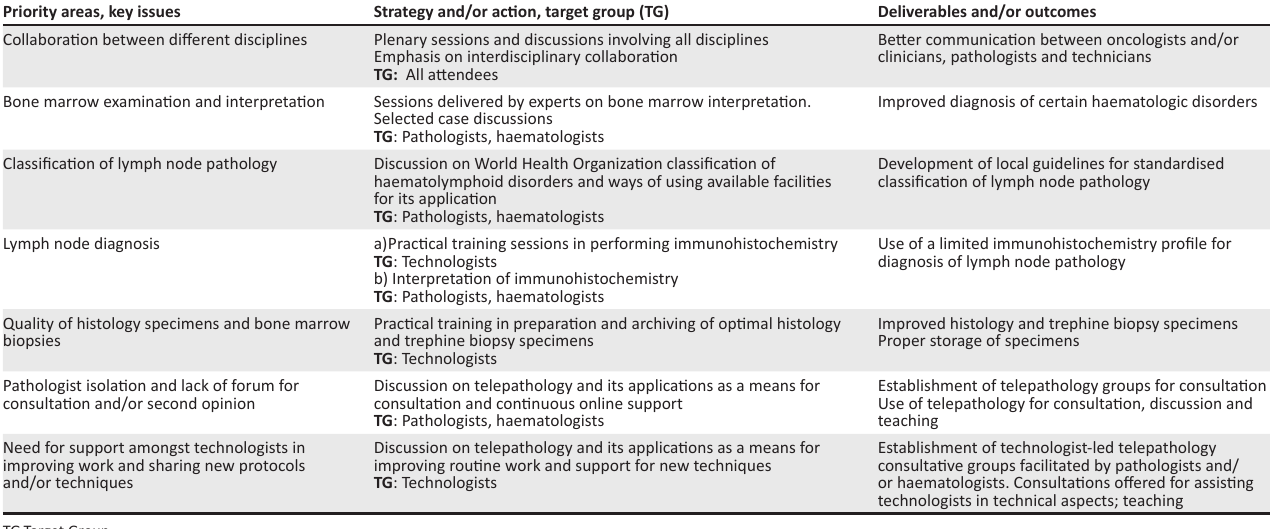
TABLE 1: Examples of training priority areas, key issues, strategies and the deliverables and/or outcomes of a haematopathology training workshop. Priority areas, key issues